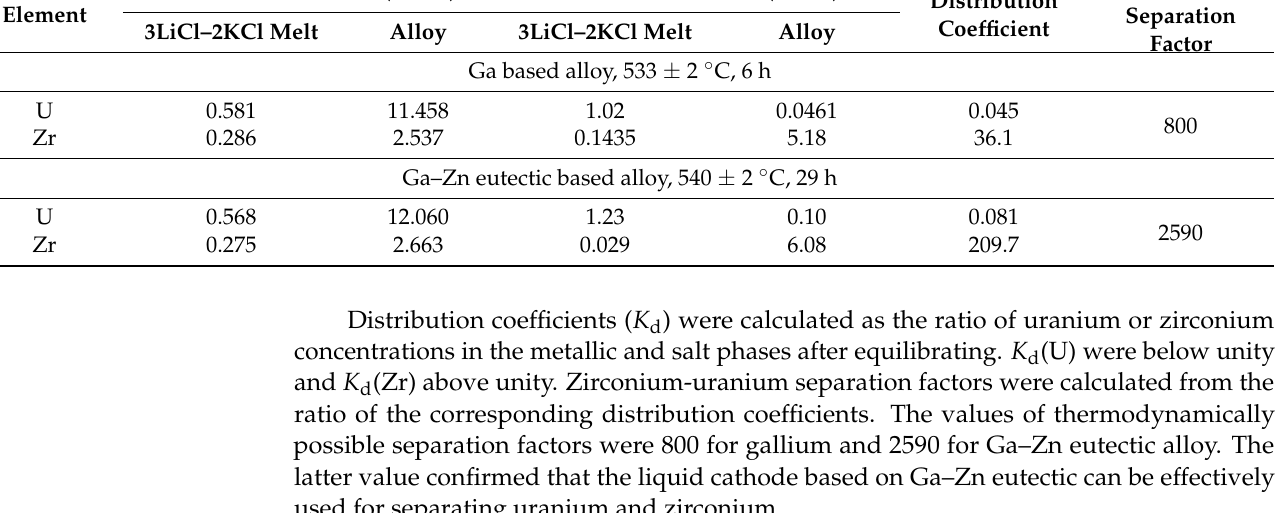
Table 1. Composition of the salt melt and metallic alloy in the experiment on assessing U/Zr separation factor in a “molten salt—liquid metal” system. Initial Concentration (wt. %) Final Concentration (wt. Element